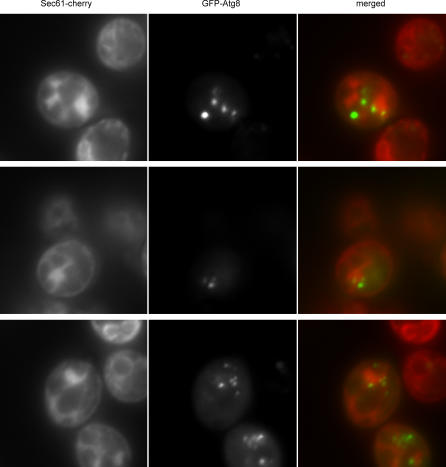
Localization of GFP-Atg8 during UPR InductionSome of the DTT-treated cells shown in Figure 4B expressing GFP-Atg8 and Sec61-cherry (as an ER marker) were visualized using fluorescence microscopy. GFP-Atg8 localizes in close proximity to the ERAs detected by the ER marker.